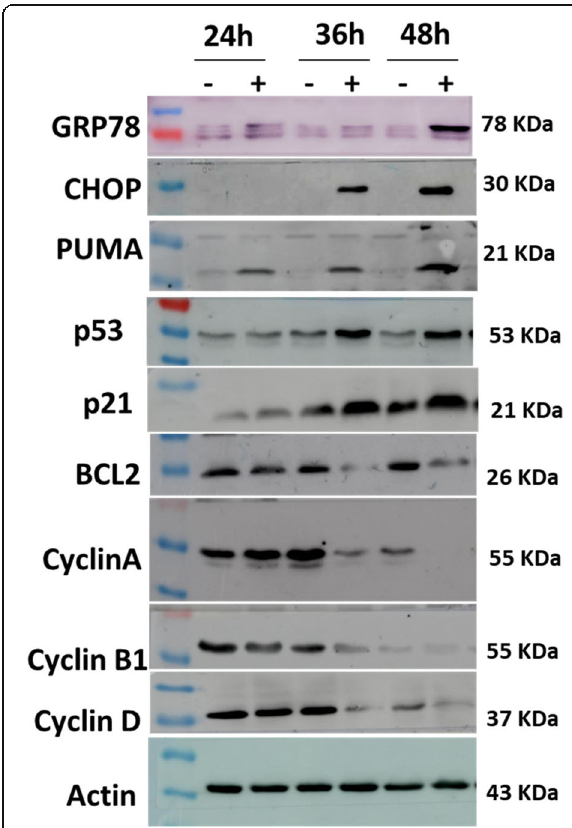
Fig. 3 Western blot analysis of some differentially expressed genes in NDL treated MCF-7 cells